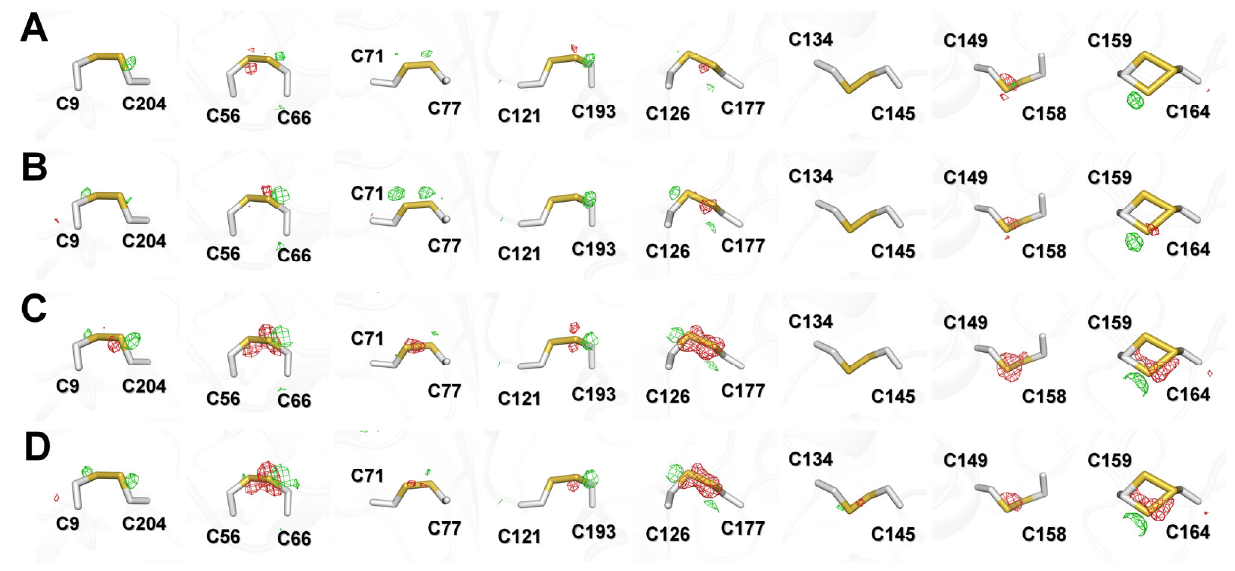
Figure 6. mFo–DFc (green mesh, 3 σ ; red mesh, − 3 σ ) electron density map of disulfide bonds in Thaumatin 100ms for ( A ) Data I (1–90°), ( B ) Data II (91–180°), ( C ) Data III (181–270°), and ( D ) Data IV (271–360°).